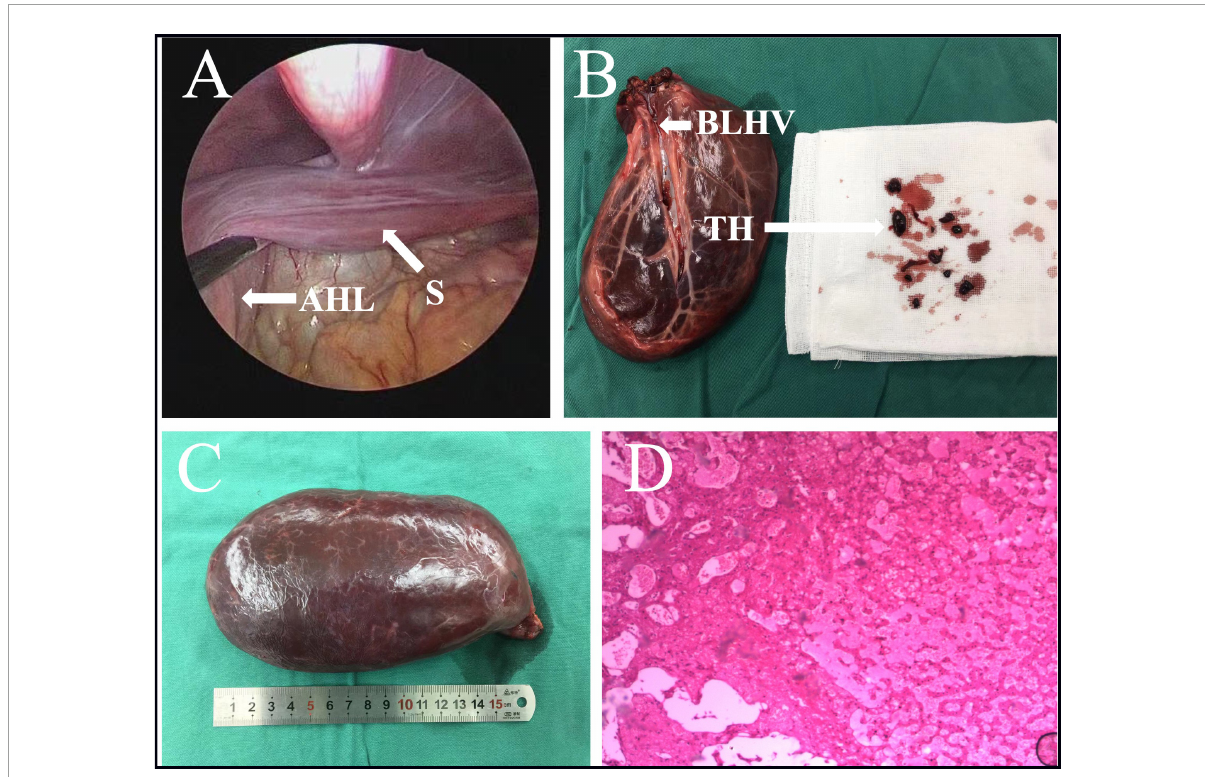
FIGURE3 (A) Intraoperative images suggested the AHL has repositioned itself, with only a stalk of approximately 2 cm in diameter liver tissue forming an attachment to the left liver. (B,C) Excision of large AHL with thrombosis of a branch of the left hepatic vein. (D) The histopathology result demonstrated the irregular structure of the hepatic lobules, dilated hepatic sinusoids, and disordered vascular distribution in the portal area and interlobular. AHL, accessory hepatic lobe; S, stalk; TH, thrombosis; BLHV, branch of the left hepatic